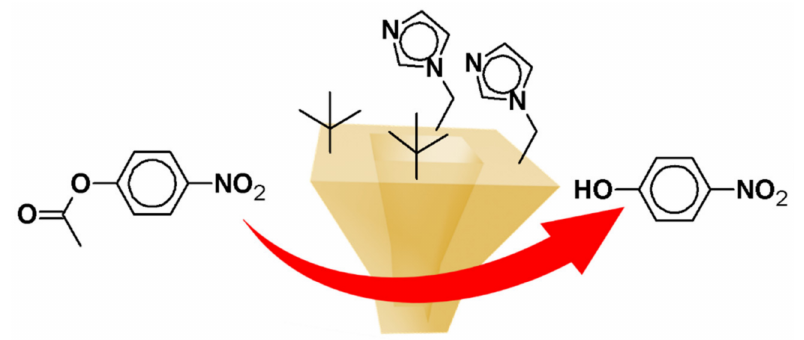
Figure 11. The hydrolysis of p -nitrophenyl by modified C[4].